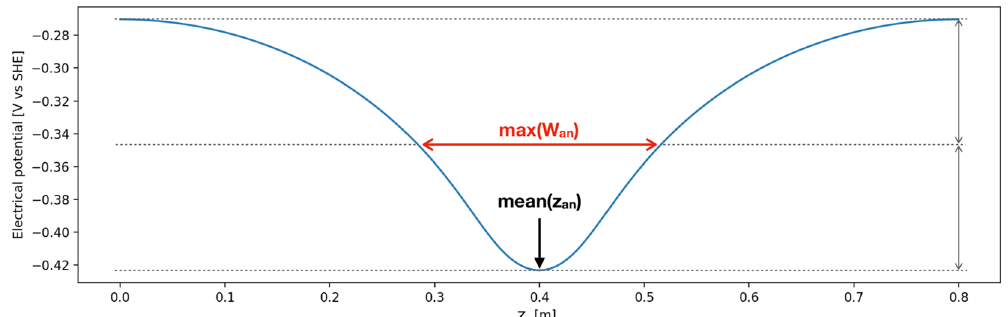
Fig. 10 Estimation of the prior information for the anode based on potential measurements at the surface. The sketch illustrates the determination of the prior information for the location of the centre of the anode ( z an ) and the width of the anode ( W an ), based on the measurable potential distribution at the concrete surface. W an is described by a uniform probability density with 0 < W an < max( W an ), where max( W an ) is determined as shown. z an can be described with a normal probability function with the mean as shown here and a standard max ð W an Þ deviation of 1 4